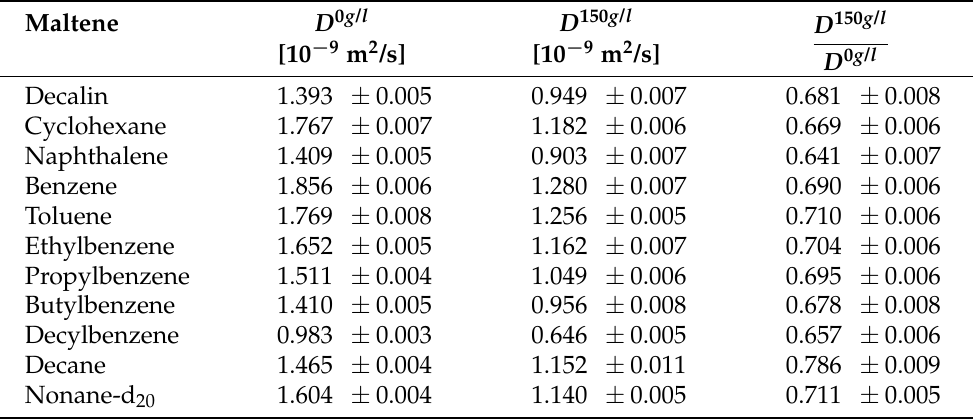
Table 3. Diffusion coefficients of the maltenes in absence and presence of the asphaltene. The D 150 g / l / D 0 g / l ratio reflects the impairment of the translational motion of the maltenes due to the presence of the